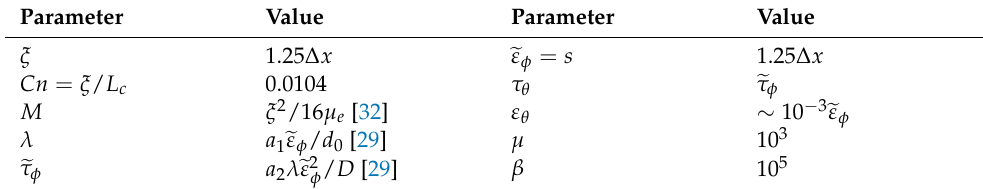
Table 2. Fitting parameters in the phase field model.